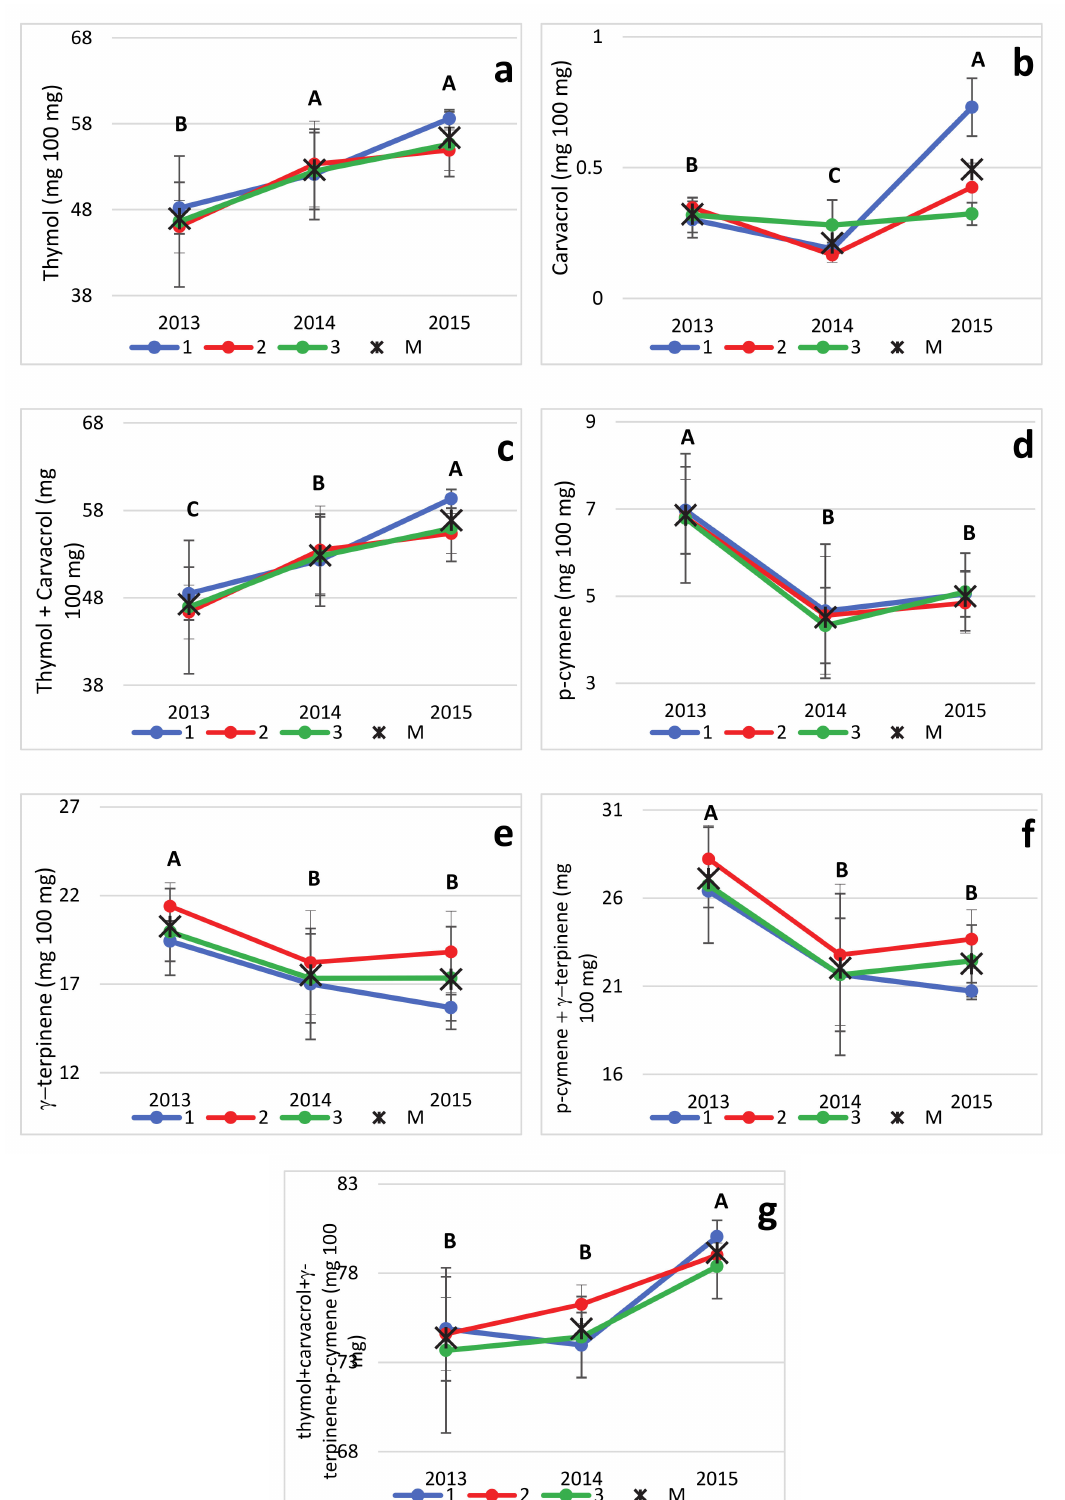
Figure 6. Trends over the years (2013 to 2015) of percentages of thymol ( a ), carvacrol ( b ), thymol + carvacrol ( c ), p -cymene ( d ), γ -terpinene ( e ), p -cymene + γ -terpinene ( f ) and thymol + carvacrol + p -cymene + γ -terpinene ( g ) in the EOs of Origanum heracleoticum grown in 3 Sicilian locations (1, 2 and 3). Within each graph, an asterisk (*) indicates the mean year value, and the letters above, when di ff erent, indicate significant di ff erences among years at p ≤ 0.05 (Tukey’s